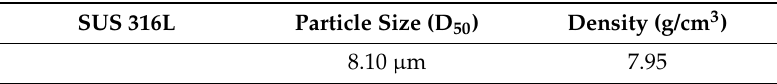
Table 1. Particle size and density of metal powder (SUS 316L) used.